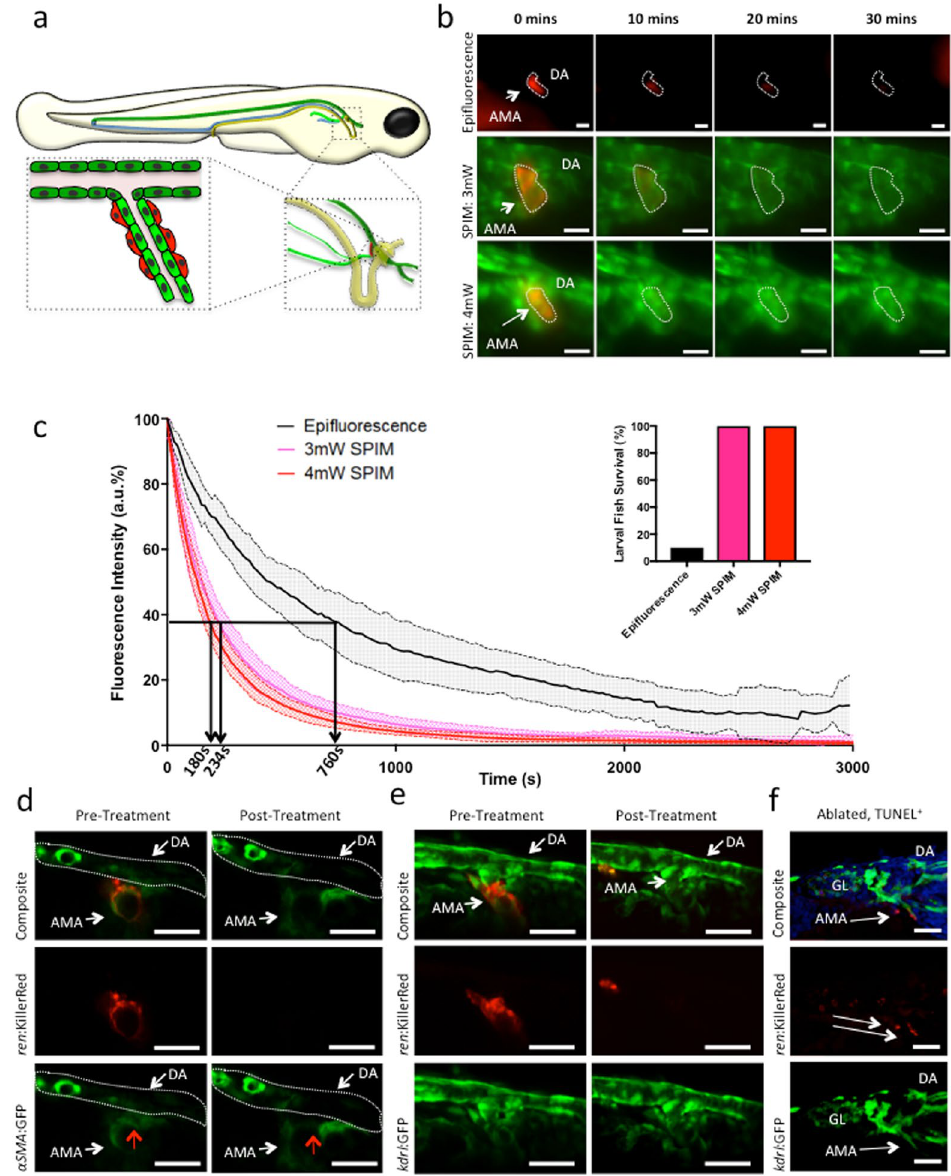
Figure 1. Evaluation of KillerRed optical targeting in vivo using epifluorescence and SPIM. ( a ) Schematic showing perivascular renin cell location in 3 dpf zebrafish. Mural renin cells are shown in red, arterial vessels in green, veins in blue, and the glomerulus (GL), nephron and cloaca in yellow. The dorsal aorta (DA) is distinguished from the anterior mesenteric artery (AMA) by using dark and light green to represent them, respectively. ( b ) ren: mem- KillerRed cells along the AMA budding off the DA in 3 dpf ren: mem-KillerRed; kdrl :GFP fish were illuminated using either an epifluorescence microscope (top panel, mCherry filter, 1hr), or the SPIM light-sheet at 3 mW or 4 mW (bottom panels, maximum intensity projections, 561 nm laser, 1hr). Representative images from 0, 10, 20 and 30 min illumination are shown. ( c ) Graphs showing the fluorescence intensity as a percentage of maximum intensity (arbitrary fluorescence, a.u.), plotted against time and averaged over n = 6 fish (with 95% confidence intervals, indicated by the filled dashed lines). Arrows and rotated times at foot of arrows indicate the 1/e value. Inset: percentage of fish surviving following illumination by epifluorescence or light-sheet microscopy for 1 hr (n = 18). ( d ) Morphological changes of ren: mem-KillerRed cells were assessed using multiphoton microscopy (MPM). MPM images of 3 dpf ren :mem-KillerRed; α SMA :GFP renin-expressing cells were taken prior to- and post-treatment using the SPIM light-sheet. Images are presented as single depth slices. Red arrows indicate renin cells. ( e ) Endothelial cell structure prior to- and post-light treatment using the SPIM light-sheet was assessed using MPM in 3 dpf ren :mem-KillerRed; kdrl :GFP fish. Images are presented as maximum intensity projections. ( f ) Apoptosis of ren: mem-KillerRed cells was confirmed using an Apop-Tag in-situ TUNEL staining kit on 15 μ m sections of 3 dpf ren: mem-KillerRed; kdrl :GFP larvae illuminated with the SPIM and fixed immediately. White arrows designate apoptosis-positive post-treatment KillerRed + cells. Images show a maximum intensity projection over 5 μ m using confocal light scanning microscopy. All scale bars represent 30 μ